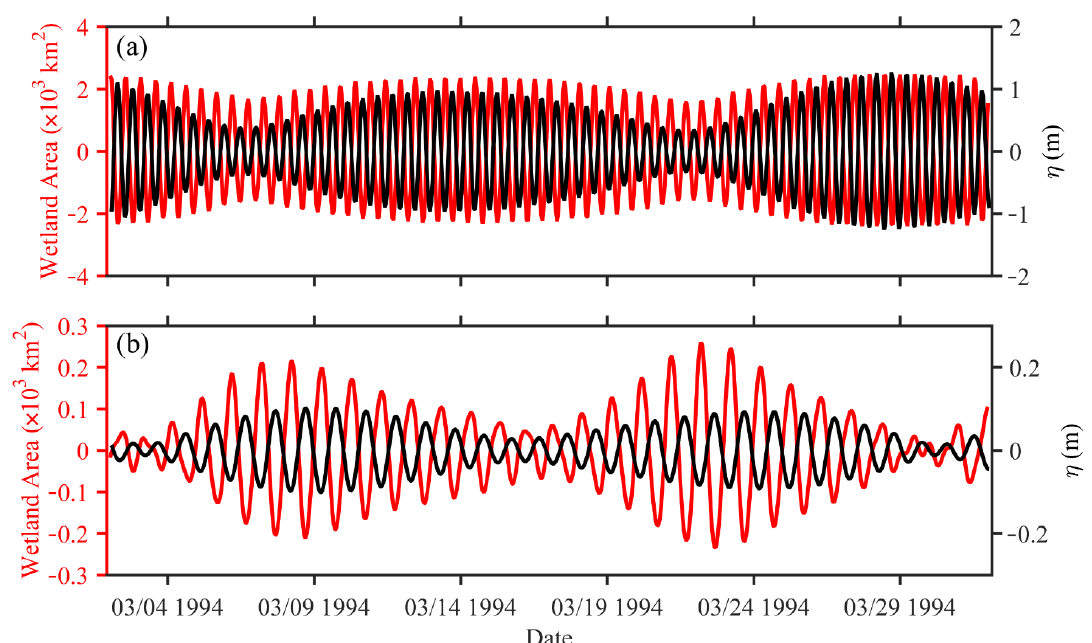
Figure 7. The time series of ( a ) semidiurnal wetland area (red line) and the sum of M 2 and S 2 sea surface heights (black line), and ( b ) diurnal wetland area (red line), the sum of K 1 and O 1 sea surface heights, and wind-induced sea surface height.